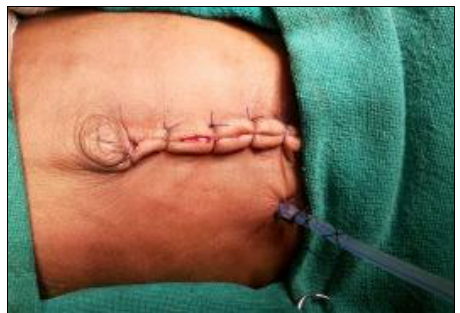
Figure 4: The gastrostomy tube was anchored externally with the needle-free ends of the thread already brought out through cannula. The gastrostomy tube was also fixed with an additional silk